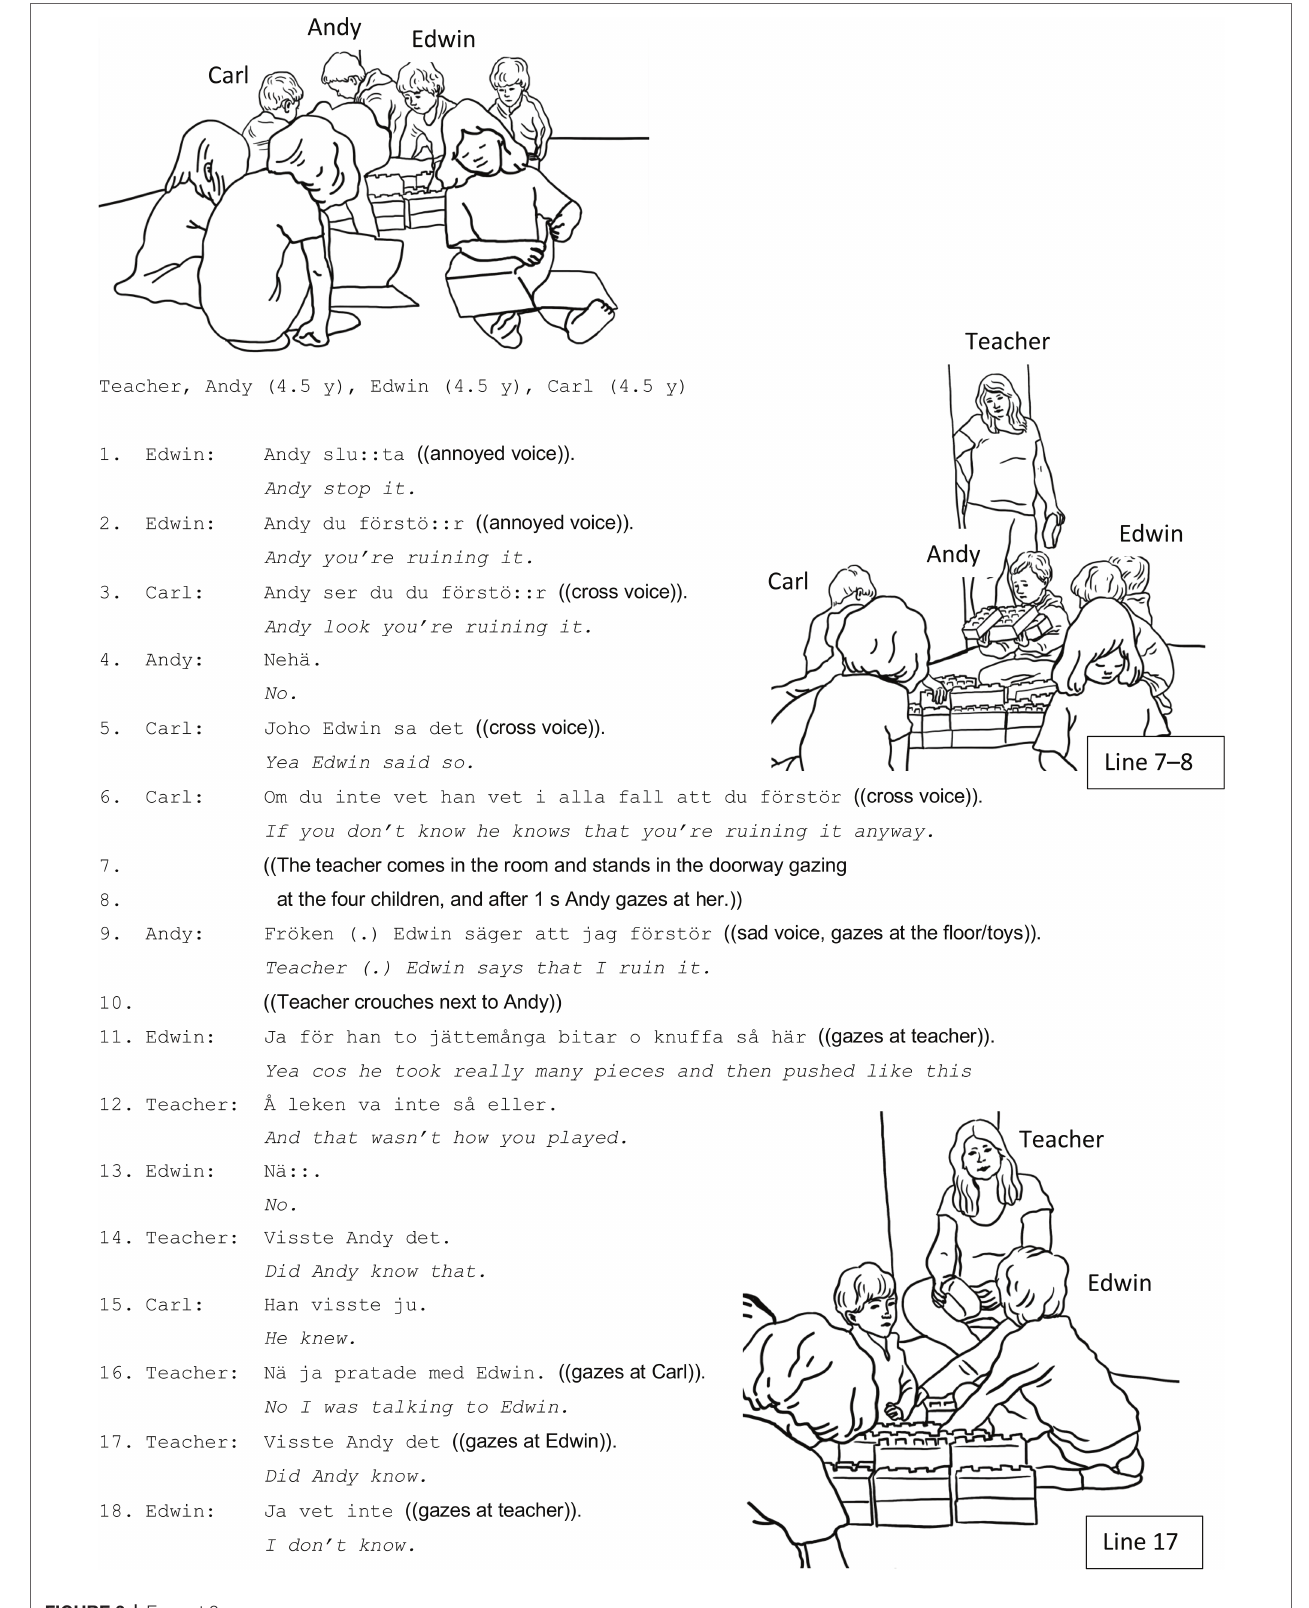
FIGURE 3 | Excerpt